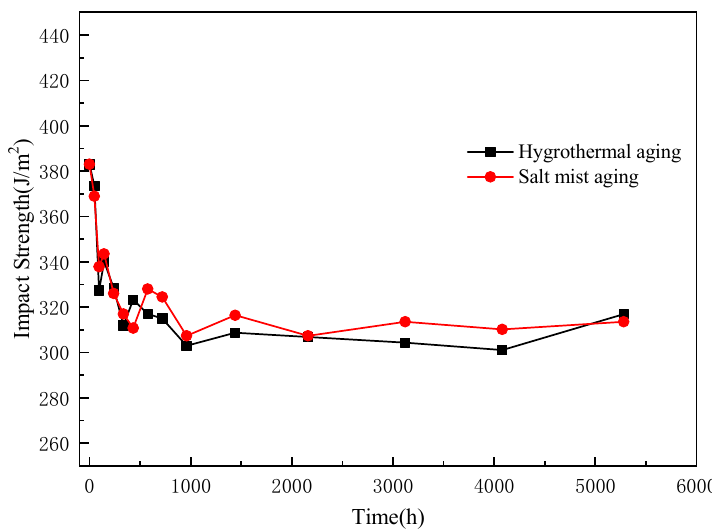
The impact strengths of the epoxy pultruded composites at different ageing times are shown in Figure 11.